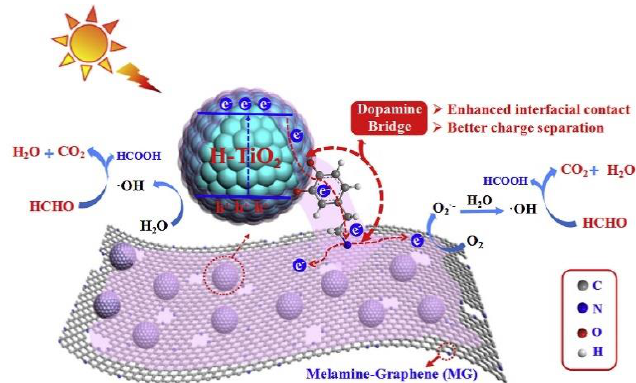
Figure 5. Schematic illustrations for dopamine bridged Melamine-Graphene/TiO 2 nanocapsule and photocatalytic degradation process of HCHO. Reprinted with permission from [58]. Copyright 2018, Elsevier.